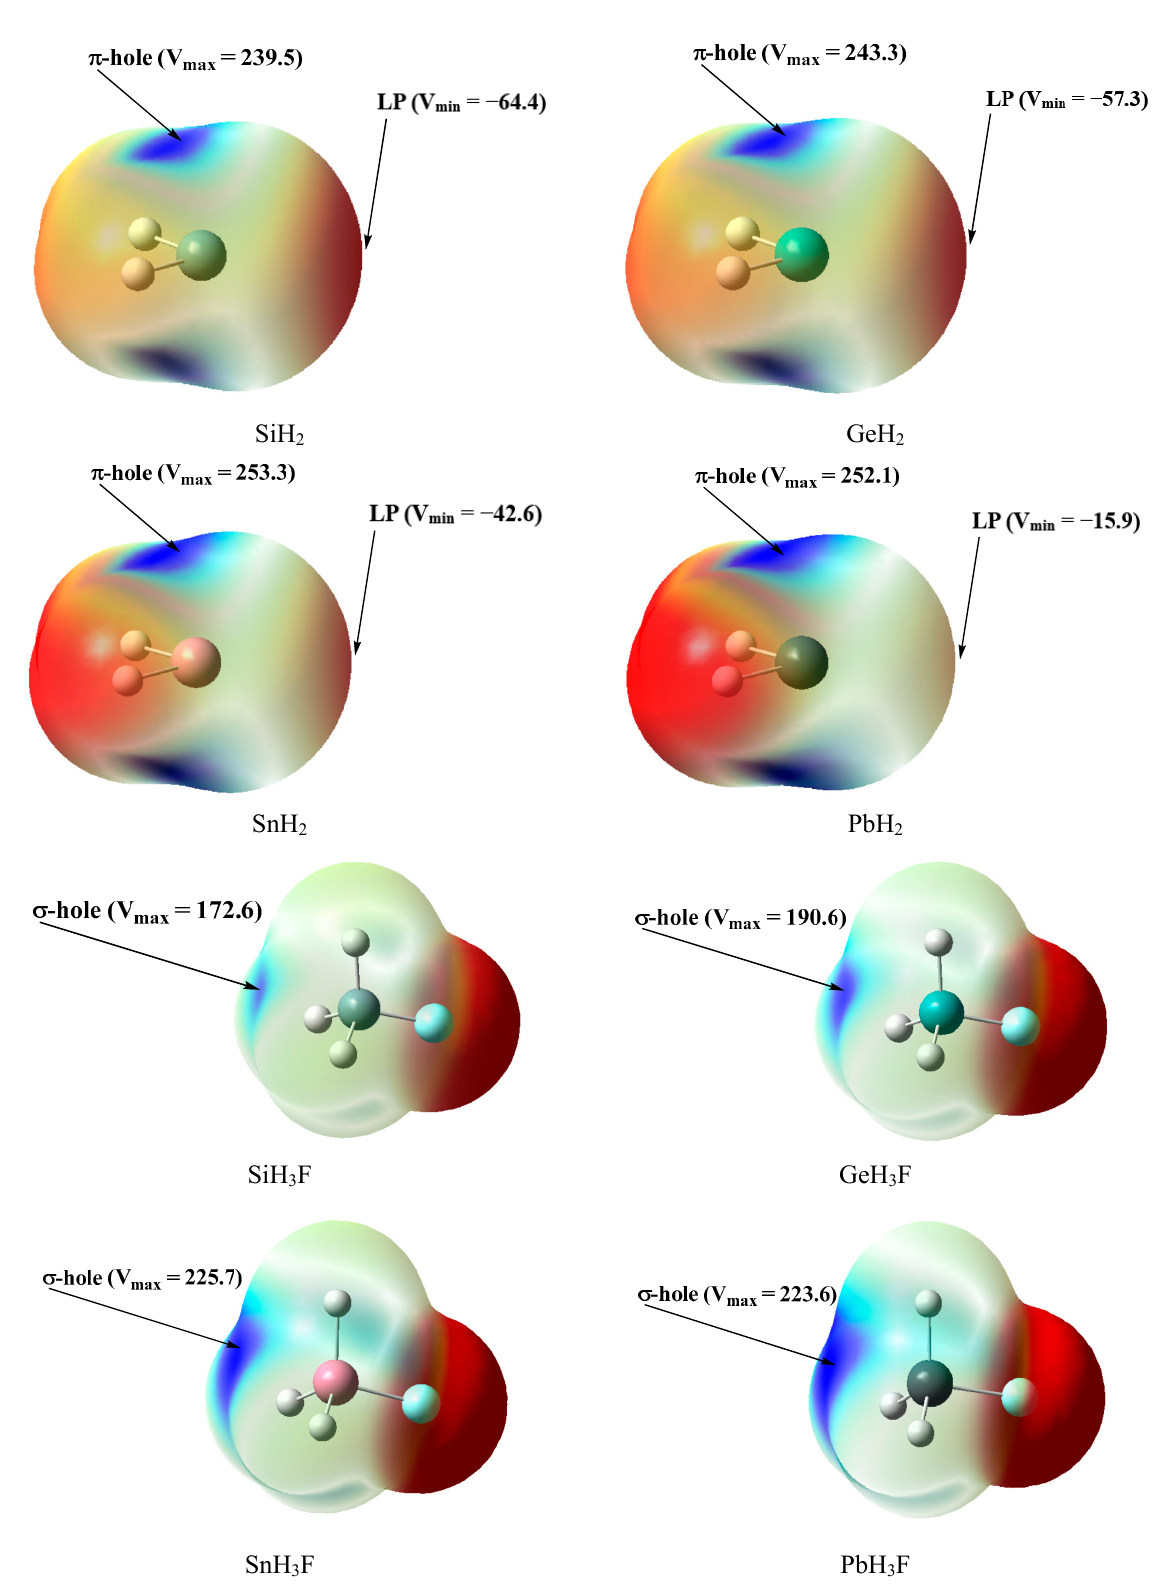
Figure 3. MEP surfaces of the monomers TH 2 and T'H 3 F at the MP2/aug-cc-pVDZ level, V S,max and V S,min in kJ/mol.